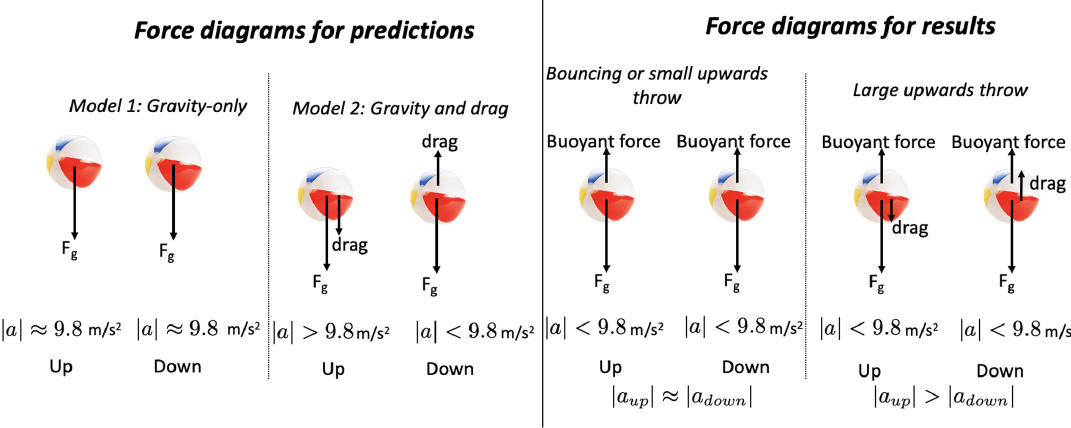
FIG. 1. Qualitative representations of the models students are asked to predict and what their results reflect. The students are asked to predict the accelerations of the balls using two models. Model 1 is if the ball only experiences a force of gravity. Model 2 is if the ball experiences both gravity and drag. The prediction of model 1 is that the acceleration of the ball is a constant 9 . 8 m = s 2 . The prediction for model 2 is that the acceleration of the ball is greater than 9 . 8 m = s 2 on the way up and less than 9 . 8 m = s 2 on the way down and nonconstant throughout the trajectory. Students find that the measured acceleration is below 9 . 8 m = s 2 in magnitude in both directions, which indicates the presence of another upwards force. If the students drop the ball and let it bounce or do a small upwards throw, the acceleration upwards is indistinguishable on the way up and down and approximately constant for the entire trajectory. If they throw it up from close to the ground, the accelerations upwards and downwards at comparable points on the trajectory are distinguishable due to the presence of the drag force.